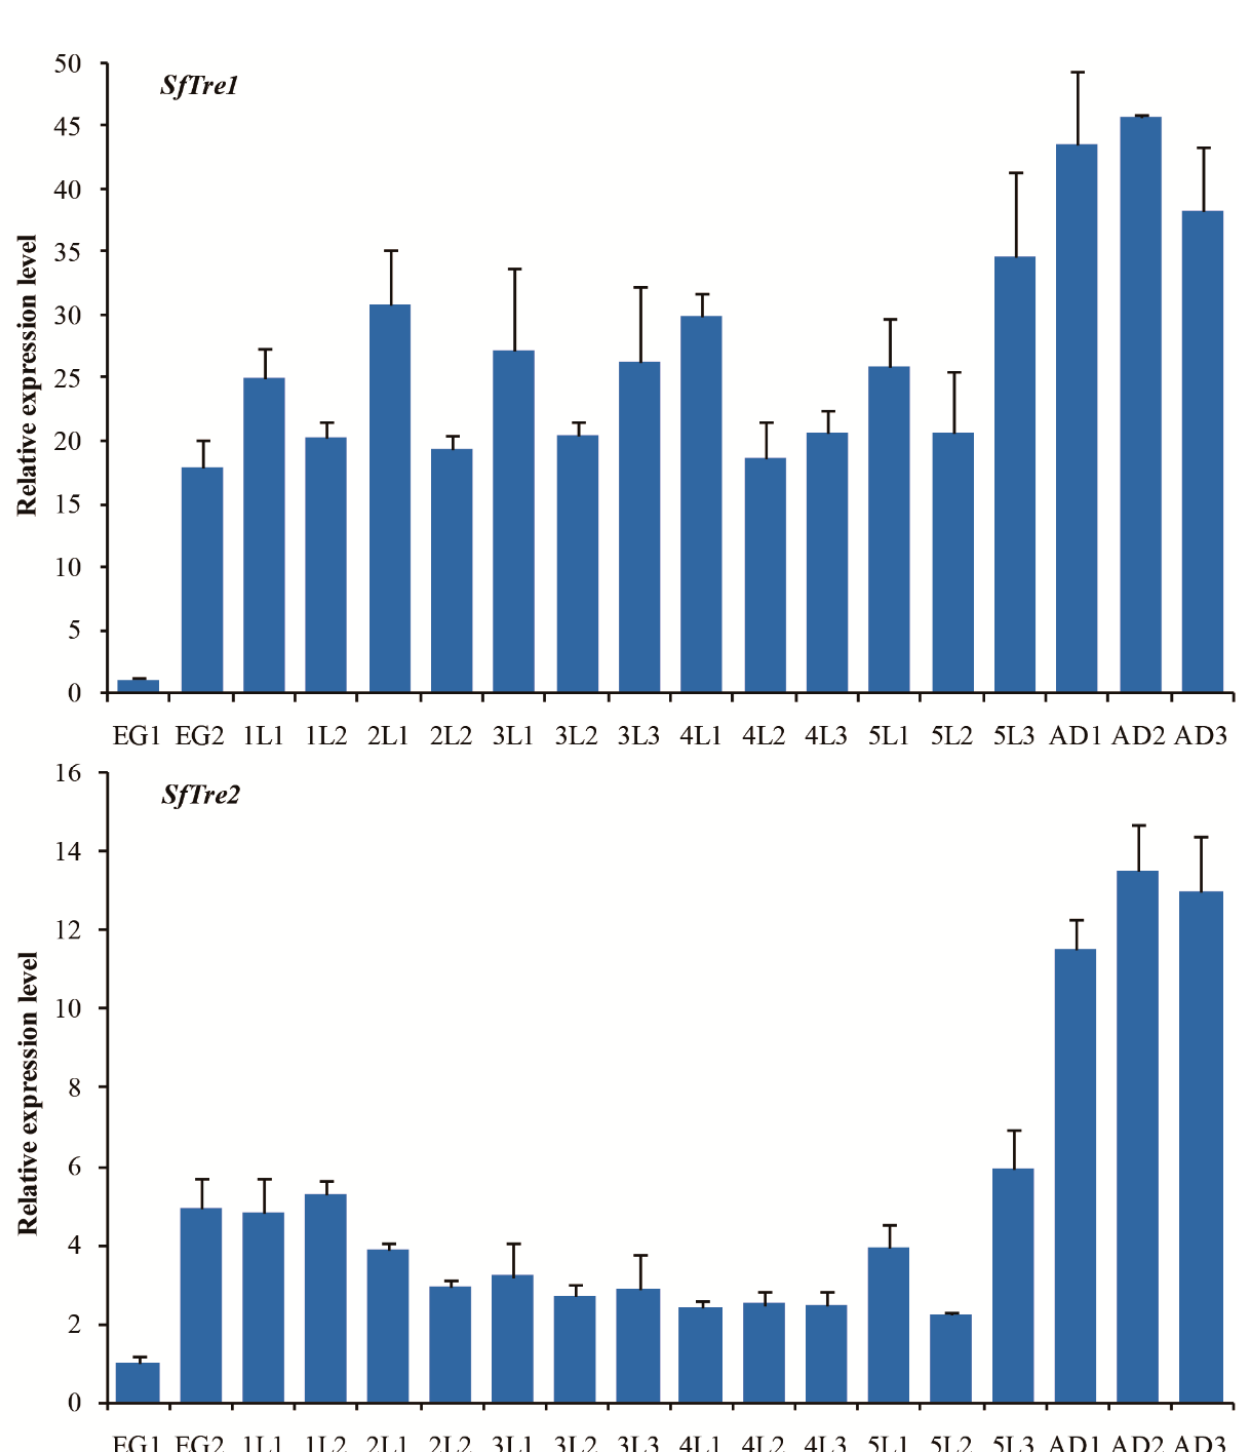
Figure 4. Expression profiles of SfTre1 and SfTre2 at different developmental stages of S. furcifera . Sf18S was used as an internal reference gene. Relative expression was determined based on the value of the lowest expression level, which was arbitrarily set to 1. Data are represented as means ± standard error of three biological replicates. The age in days of the insects is shown; for example, EG1 indicates the first day of eggs; lL1 indicates the first day of a first-instar nymph; AD1 indicates the first day of adults.